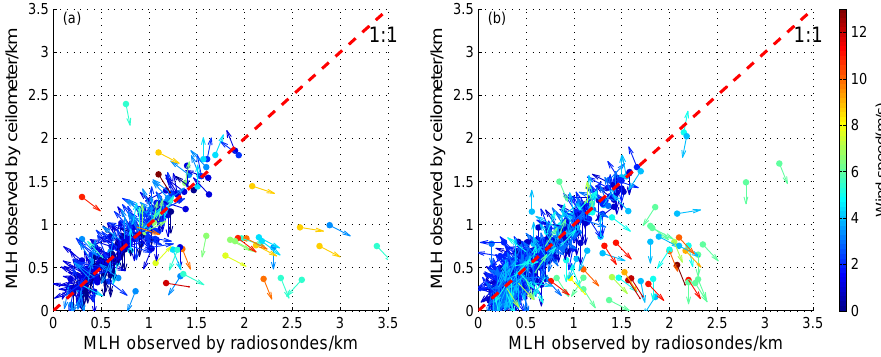
Figure 4. Comparison of MLH between radiosondes and the ceilometer according to wind vectors for convective (a) and stable (b) states.